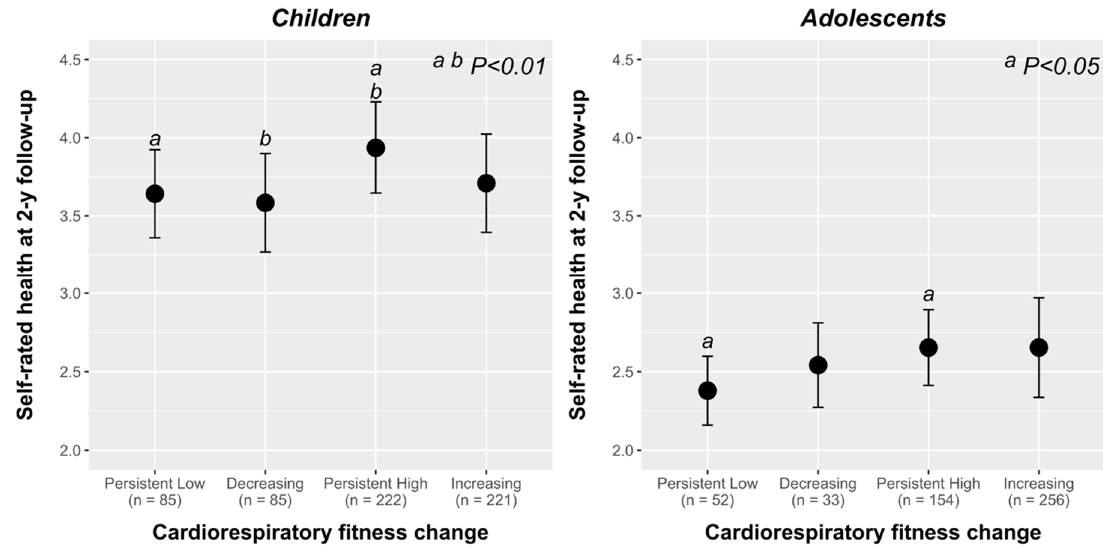
Figure 2. SRH at follow-up according to cardiorespiratory fitness change categories (persistent low, decreasing, persistent high, or increasing) in children and adolescents. Gender, BMI, and pubertal status at 2-year follow-up and SRH at baseline were included as covariates in the model. Categories with the same letter indicate a significant pairwise difference using a post-hoc analysis with Bonferroni correction.